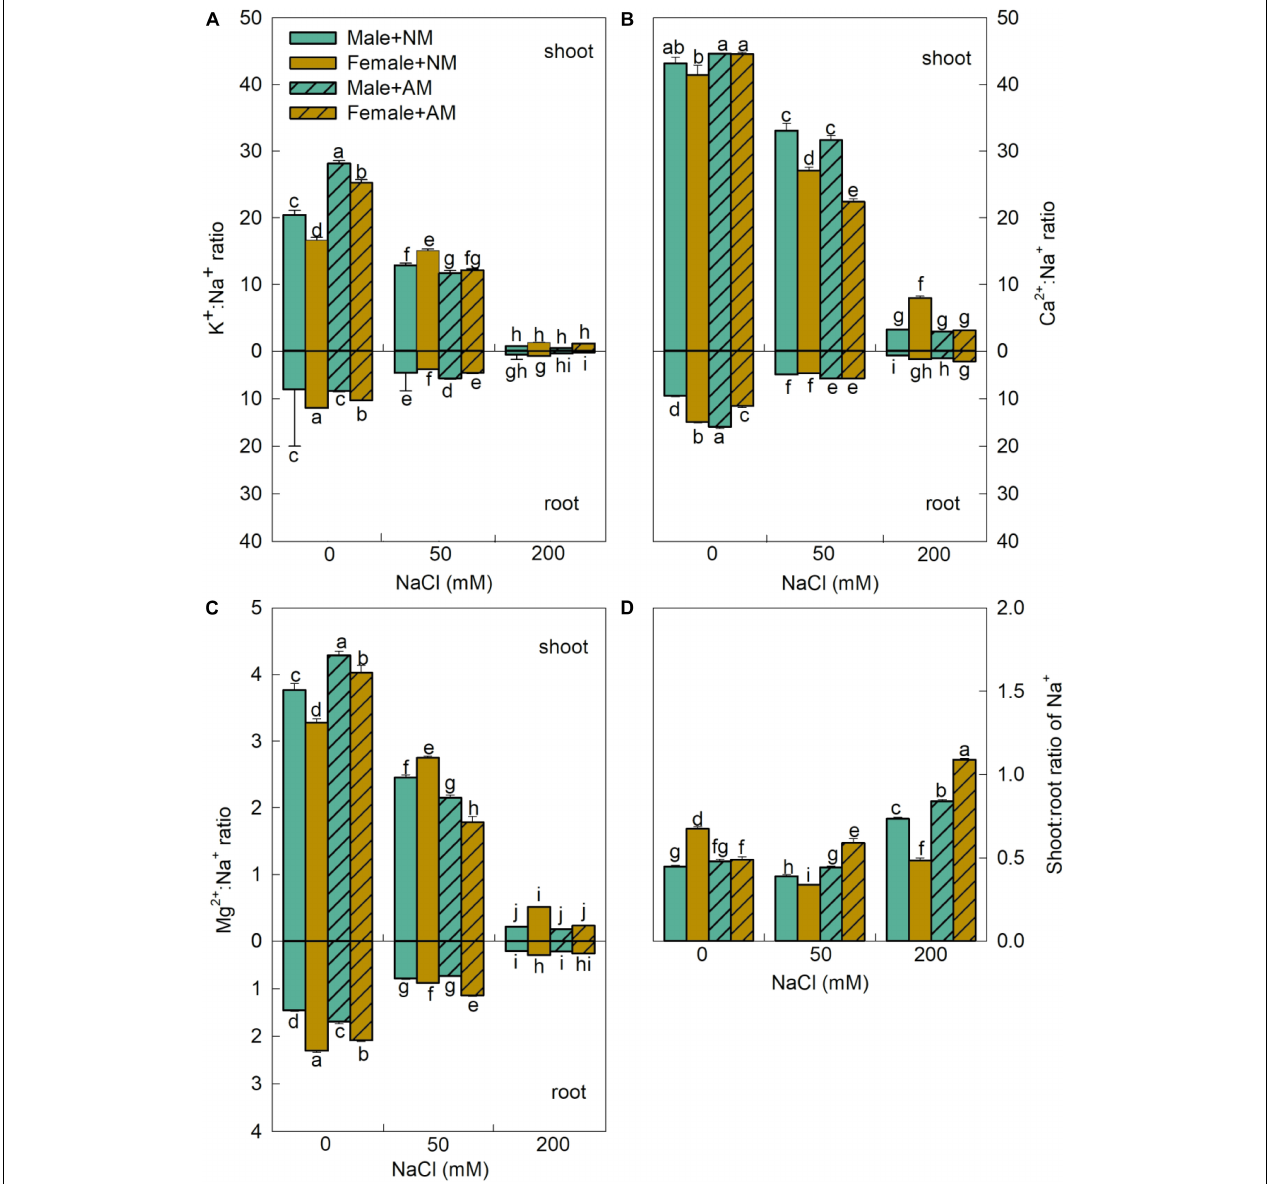
FIGURE 6 | Effects of arbuscular mycorrhizal fungus on K + /Na + ratio (A) , Ca 2 + /Na + ratio (B) , Mg 2 + /Na + ratio (C) of shoots and roots, and shoot/root ratio of Na + (D) in males and females of Morus alba under saline conditions. NM and AM represent inoculation with no mycorrhizal fungi and with Funneliformis mosseae , respectively. Values are presented as means ± SD ( n = 3). Three-way ANOVA is performed to compare the effects of sex, salt, and AM inoculation and their interactions in both males and females. Different letters indicate a significant difference according to least significant difference at p <